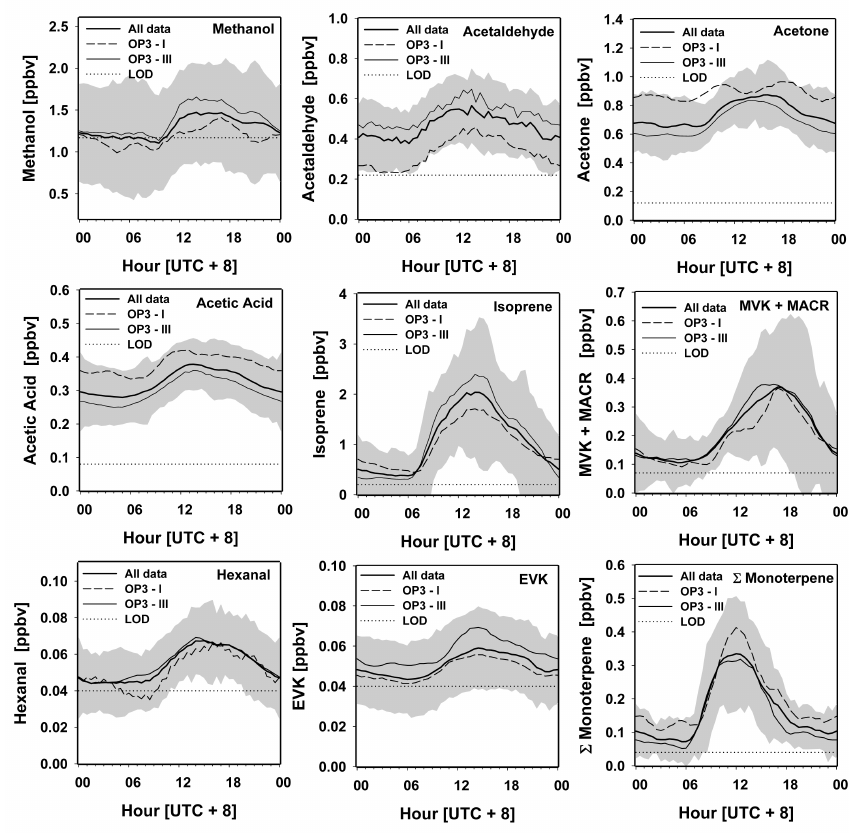
Fig. 4. Average diurnal profiles of VOC mixing ratios measured during the two intensive OP3 field campaigns which took place between 20 April–7 May (OP3-I) and 20 June and 20 July (OP3-III), 2008. Grey error bands show ± 1 standard deviation of averaged hourly values and dotted lines show the limit of detection (LOD=2 × σ background /sensitivity).